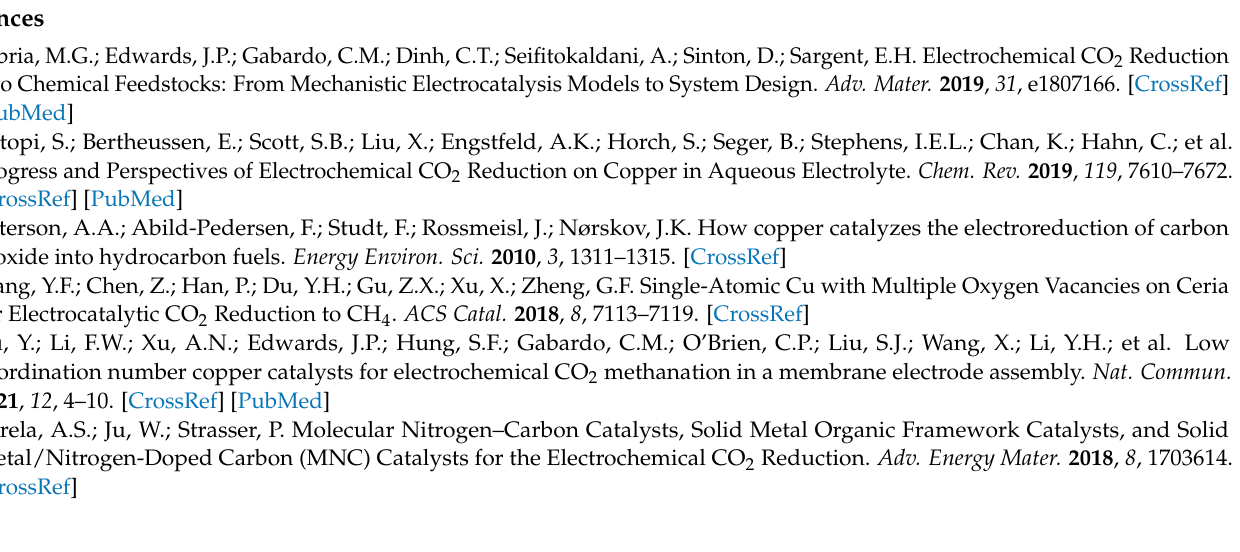
Table S2: XPS peak positions and phase assignment of the TiO 2 , Cu-TiO 2 , and Cu-TiO 2 -H samples; Figure S4: Example of a gas chromatogram (below: enlarged view in the region for CH 4 and CO) of H 2 , CH 4 , and CO obtained by electrochemical reduction of CO 2 using Cu-TiO 2 -H catalyst on a Molsieve 5A column channel after chronoamperometry operation of 10 min at 1.8 V vs. RHE; Figure S5: Example of a gas chromatogram (below: enlarged view in the region for C 2 H 4 ) of C 2 H 4 obtained by electrochemical reduction of CO 2 using Cu-TiO 2 -H catalyst on a Plot Q column channel after chronoamperometry operation of 10 min at 1.8 V vs. RHE; Figure S6: Example of a High Performance Liquid Chromatography (HPLC) of liquid products obtained by electrochemical reduction of CO 2 using Cu-TiO 2 -H catalyst after chronoamperometry operation of 10 min at 1.8 V vs. RHE; Table